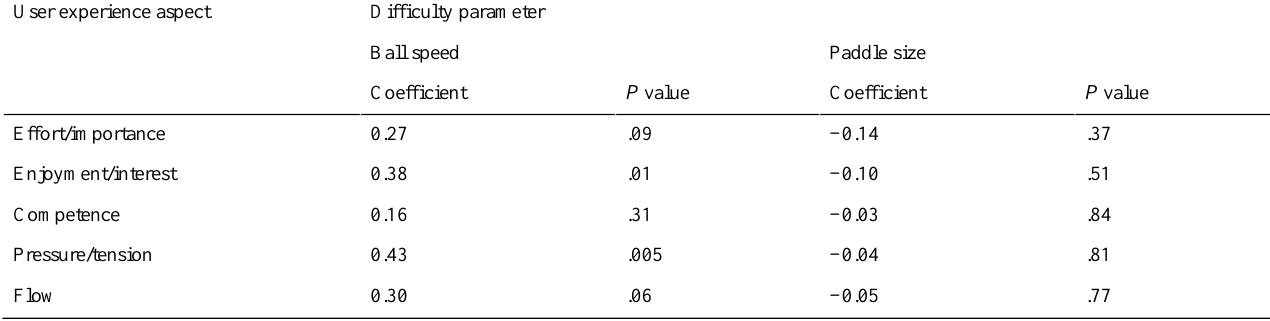
Table 4. Spearman correlation coefficients between user experience indicators and accuracy of difficulty